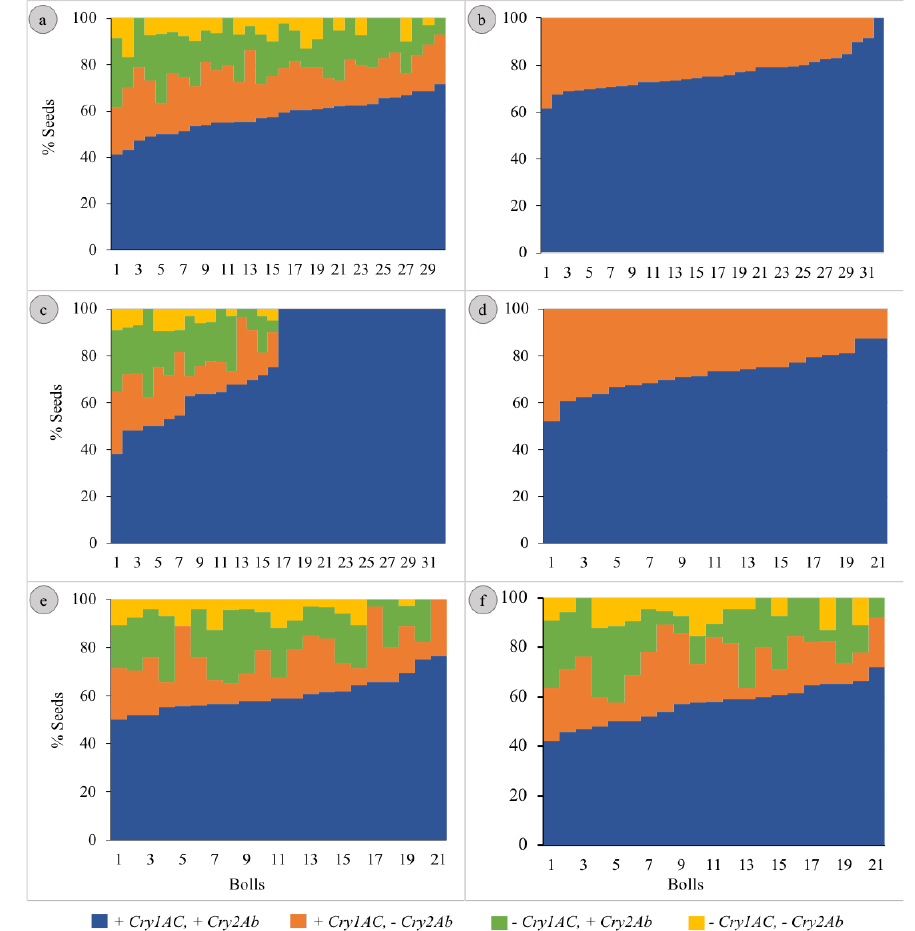
Figure 2. Boll-wise segregation of the Cry genes in the seeds of Bt cotton hybrids. [( a – f ) represent Hybrids 1 to 6, respectively. The bolls were ranked according to the proportion of + + seeds before plotting]. Table 1. Expression of the Cry genes in the seeds produced by Bt cotton hybrids. The values repre- sent percentage of seeds in a boll.